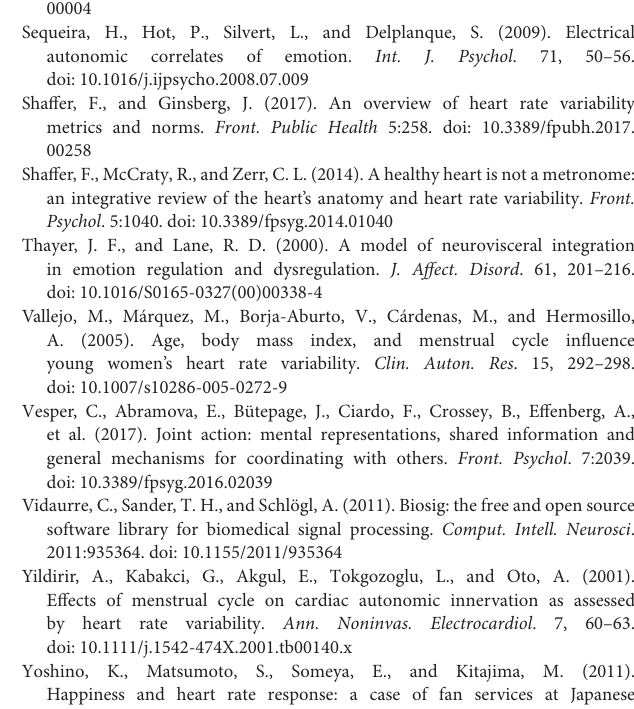
Happiness and heart rate response: a case of fan services at Japanese